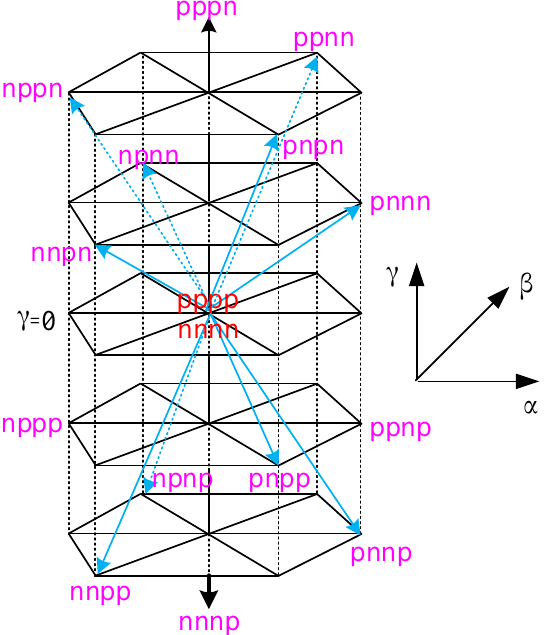
Figure 14. Vector diagram of 3D-SVPWM switch state.